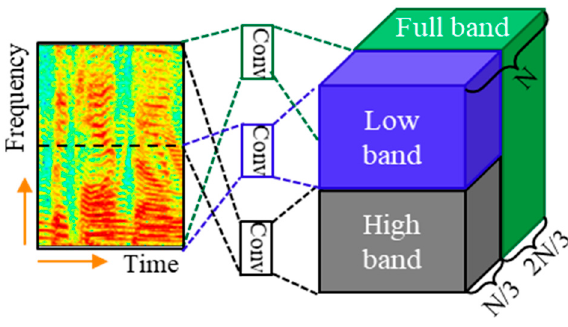
Figure 6. Multi-band block.